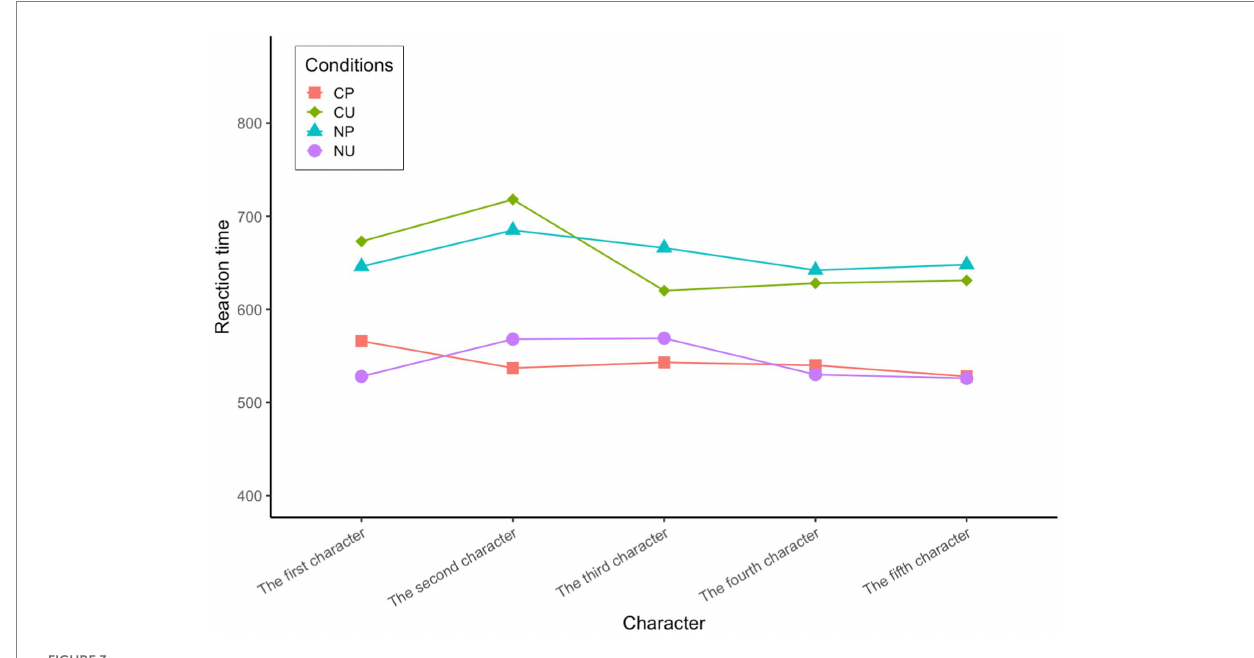
FIGURE 3 Reaction time of Chinese L2 Learners in four